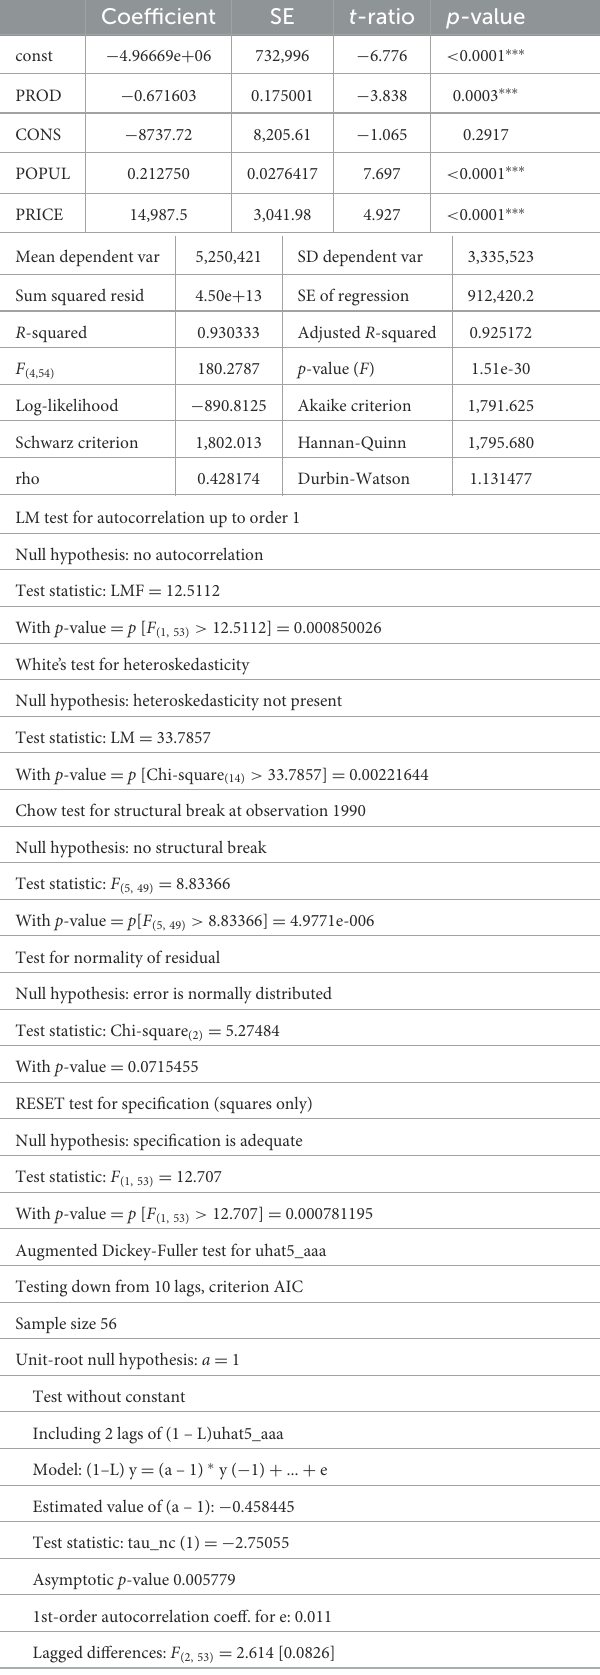
TABLE 3 Model 5: OLS, using observations 1961–2019 ( T = 59). TABLE 4 Results of estimates of ADL model in linear form—HAC standard errors using observations 2000:02–2021:02 ( T =